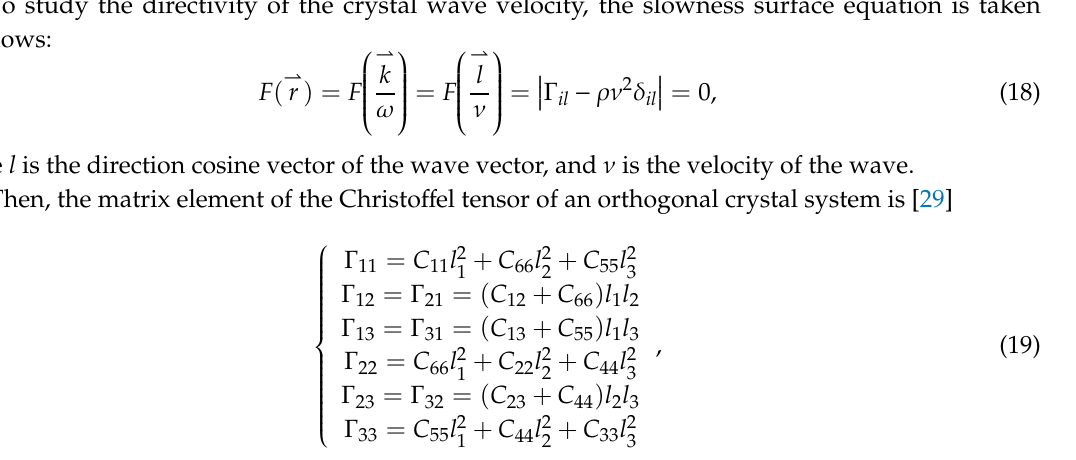
Figure 11. Variation of longitudinal, transverse and average sound velocity of polycrystalline anhydrite with pressure. with